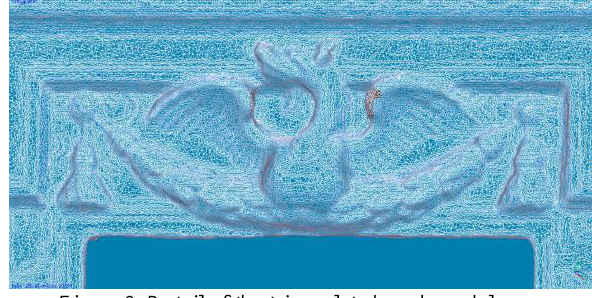
Figure 9. Detail of the triangulated mesh model